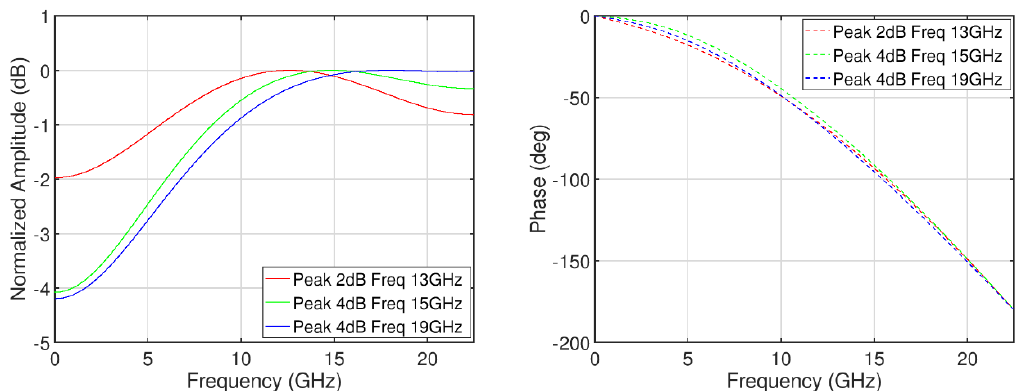
Figure 5. Normalized amplitude and phase responses of simple finite impulse response (FIR) filters with different peaking frequencies and peaking amounts. The results are obtained by applying Z-transform on the tap coefficients of the FIR filter.